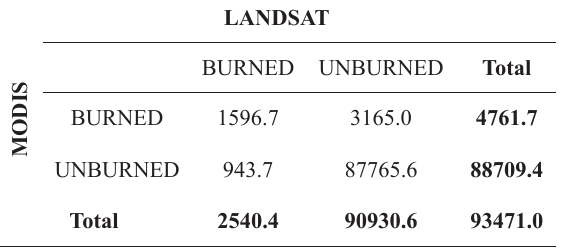
Contingency table computed according to Binaghi et al. (1999). Values correspond to fraction of pixels.